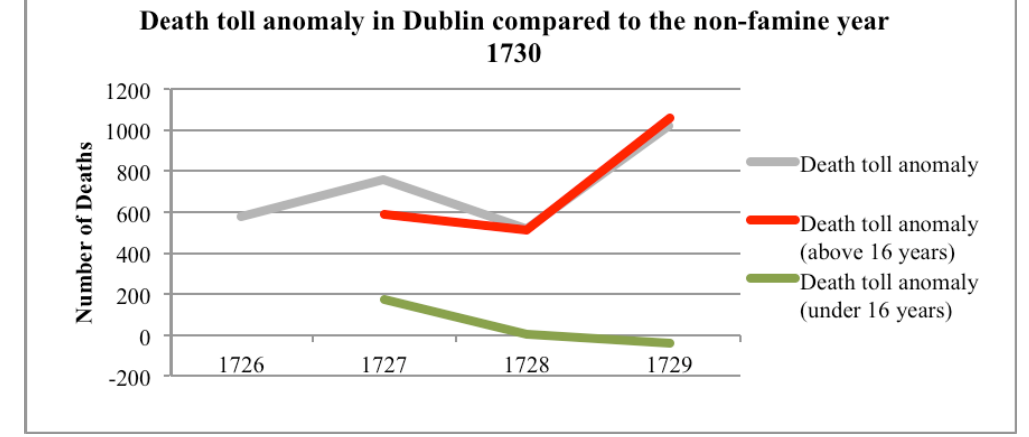
Figure 1. Death toll anomaly in Dublin compared to the non-famine year 1730. The Data was taken from “The Dublin Weekly Journal” issues